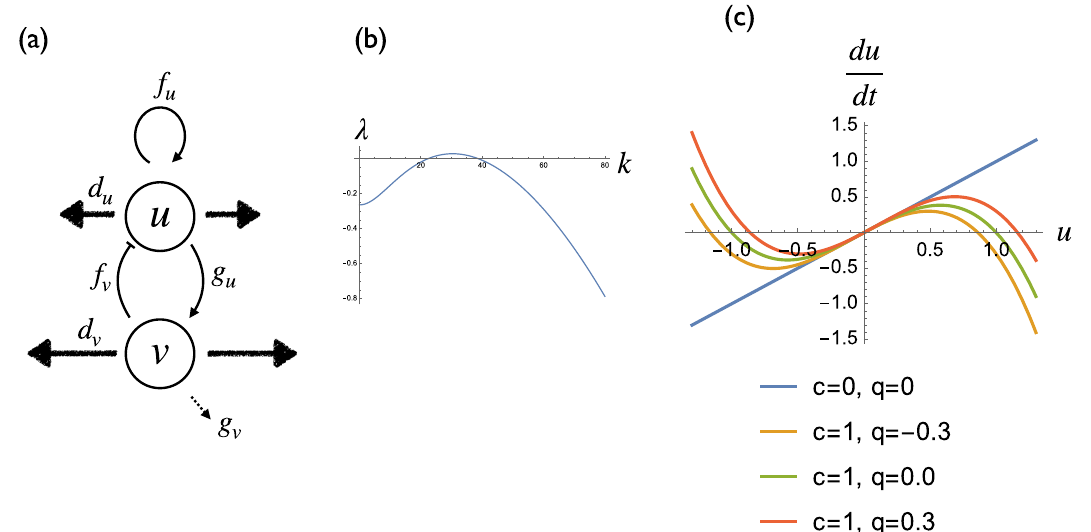
Figure 6. Definitions of the model parameters. ( a ) Schematic representation of the six linear parameters of the model. ( b ) Dispersion relation of the Eq. (2) ( f u = 0.6, f v = − 1, g u = 1.5, g v = − 2, d u = 0.0002, d v = 0.002 ). ( c ) Effect of two nonlinear terms c and q on the u